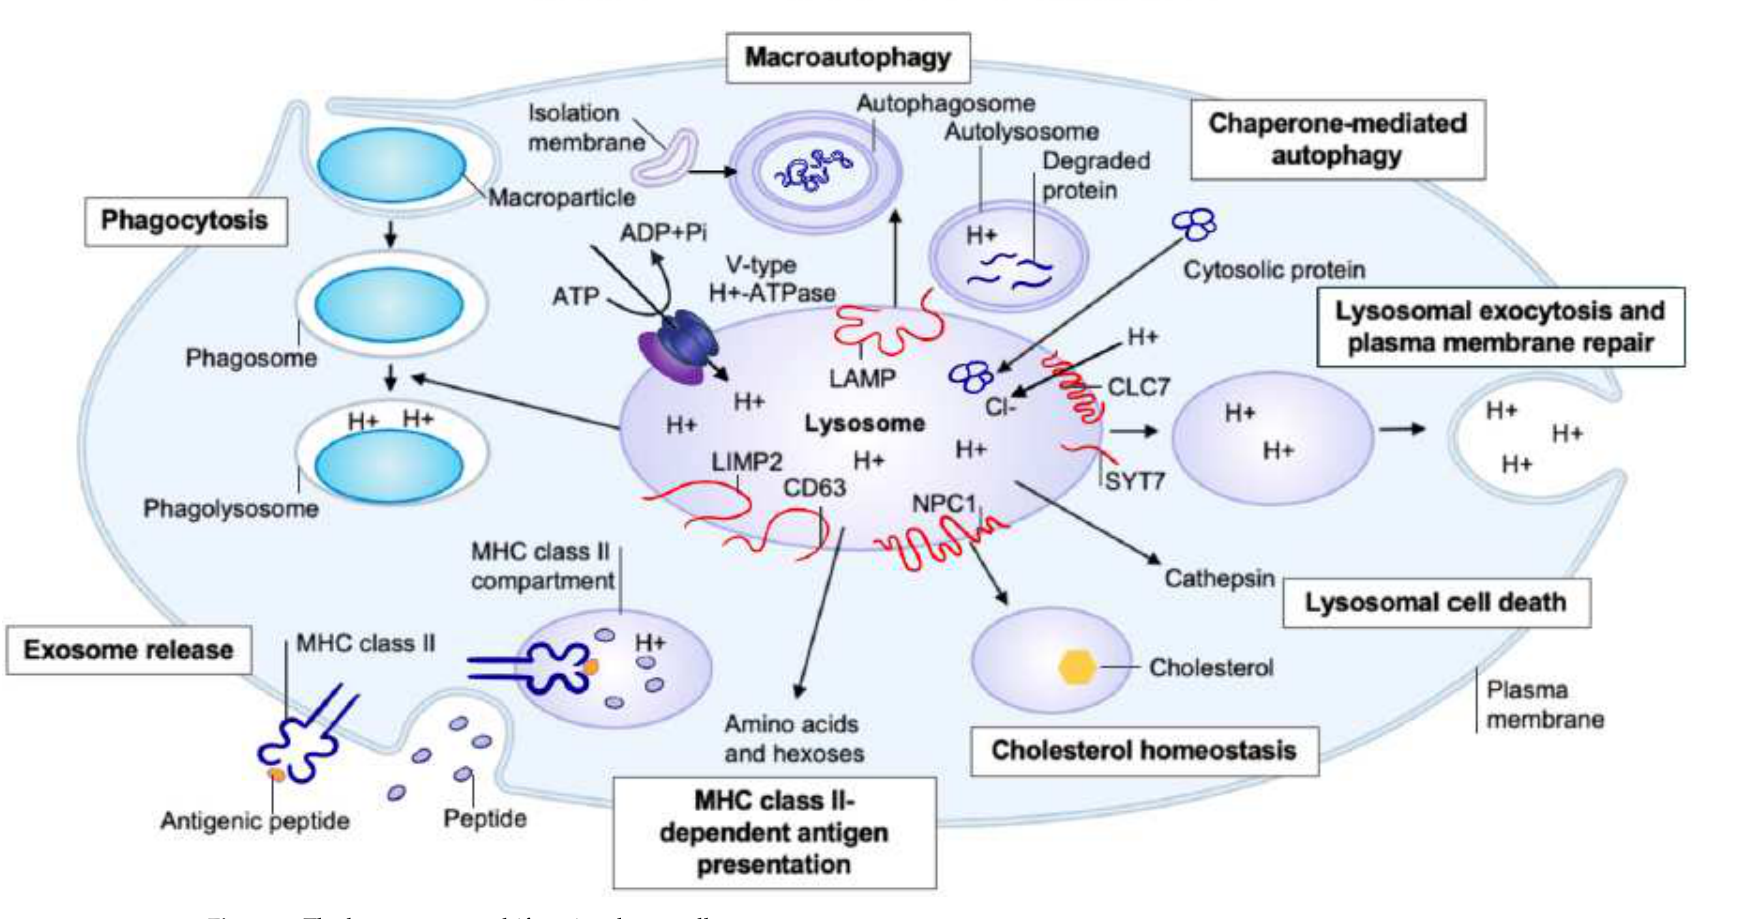
Figure 1. The lysosome: a multifunctional organelle.